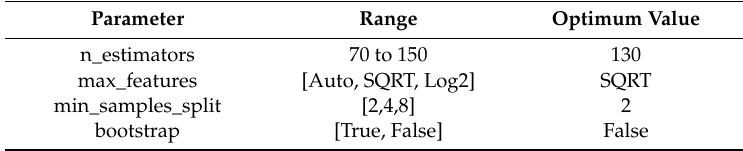
Table 2. The Random Forest (RF) grid search hyperparameters.